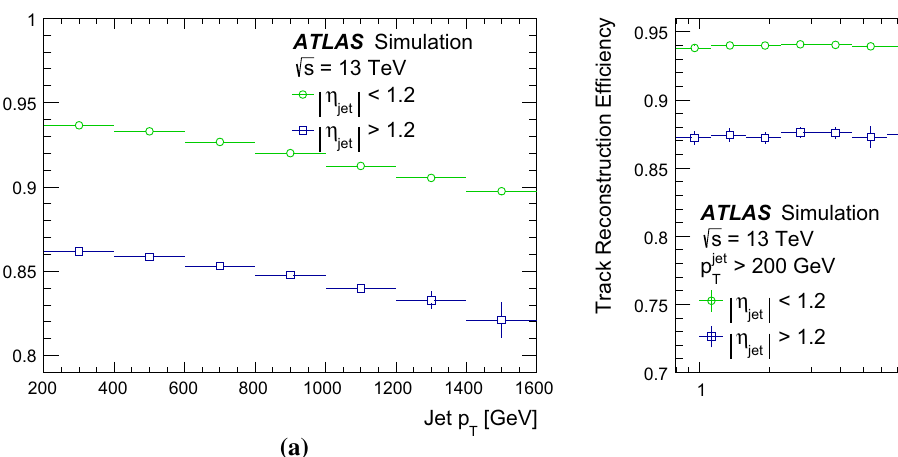
Fig. 14 The track reconstruction efficiency is compared for charged primary particles in jets with | η | < 1 . 2 ( | η | > 1 . 2) for the entire jet- p T range as a function of a the jet p T and b the production radius of the